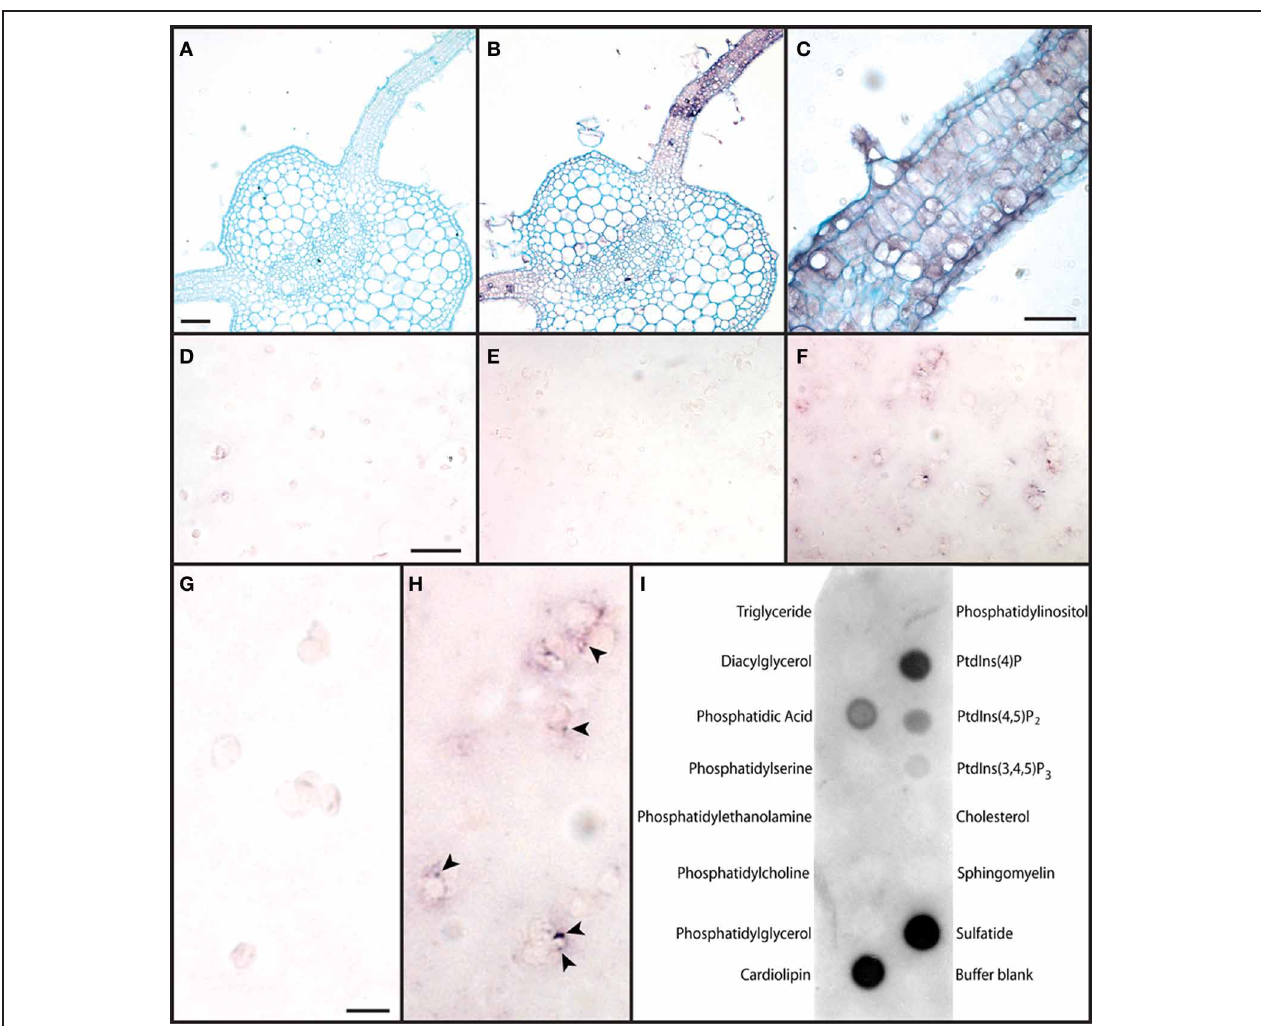
FIGURE 4 | Association of PMTV RNA with chloroplasts and TGB2 with lipids. (A) PMTV 3 (cid:3) UTR DIG-labeled sense RNA probe did not detect any viral RNA in a section of leaf infected with PMTV as shown by the lack of purple precipitate. The tissue has been counterstained with Alcian Blue to show cell structure. (Bar = 250 μ m for A and B ). (B) PMTV 3 (cid:3) UTR DIG-labeled antisense RNA probe detected viral RNA in the leaf lamina and in some parenchyma cells associated with the vascular trace in the midrib of the leaf, as shown by purple-coloration of infected cells with replicating virus. The tissue has been counterstained with Alcian Blue to show cell structure. (C) A higher magnification image of the tissue shown in (B) to show the purple coloration associated with viral RNA in many cell types in a patch of PMTV-infected leaf lamina (Bar = 100 μ m). (D) Chloroplasts from control, healthy tissue did not label strongly with the PMTV DIG-labeled antisense probe showing that there was little non-specific labeling with this